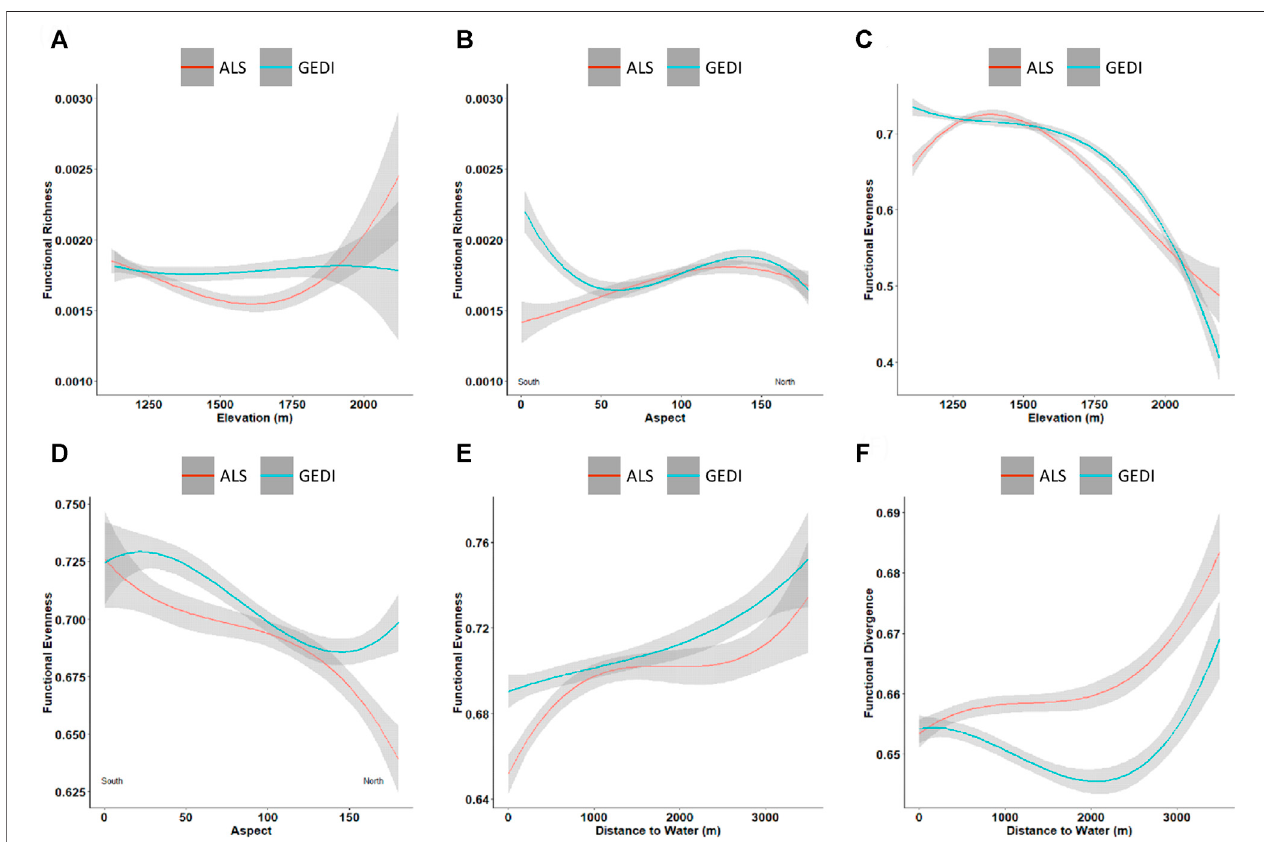
FIGURE 9 | Trends between functional diversity and abiotic controls. The red and blue curves represent the mean variation of diversity indices predicted from ALS and GEDI data, respectively, and the surrounding gray area represents the standard deviation. Functional richness with (A) elevation; (B) aspect. Functional evenness with (C) elevation; (D) aspect; (E) distance to water. Functional divergence with (F) distance to water.